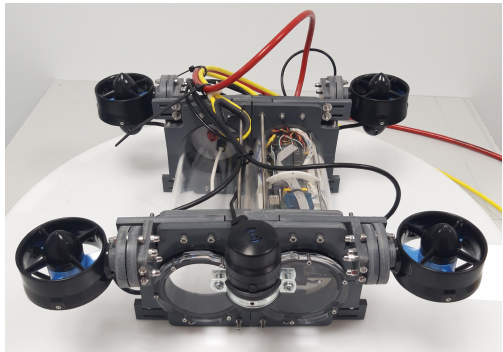
Figure 3. The underwater drone robot. The right enclosure is used for the robot’s movement and navigation electronics, and the left enclosure is used for the waterproof payload (e.g., the electronics for a robotic